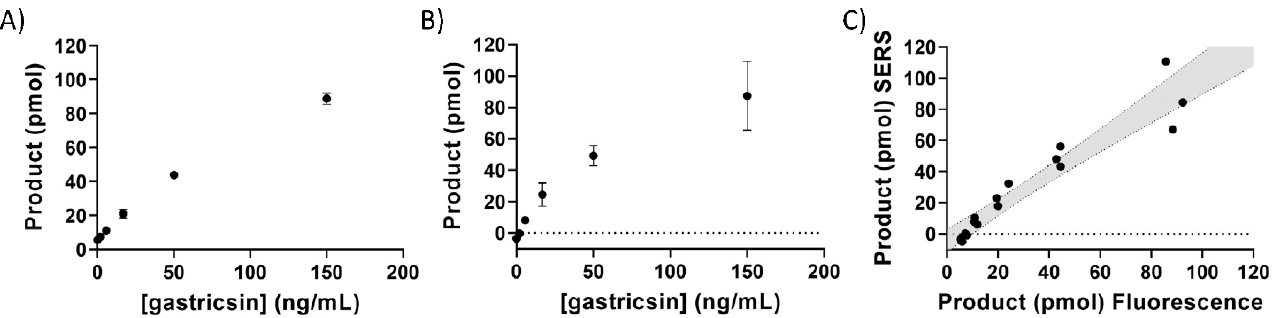
Figure 2. Gastricsin activity assay in pH 2 buffer. ( A ) The product formation is calculated from flu- orescence measurement at each concentration of gastricsin as indicated on the x-axis. ( B ) The prod- uct formation calculated from SERS measurements at each concentration of gastricsin. The samples in ( A ) were used for these measurements after addition of silver. Error bars represent the standard deviation of triplicate measurements. ( C ) Correlation of product formation between SERS and fluo- rescence measurements from paired reaction samples. The grey area is the 95% confidence interval from a linear regression analysis with a slope = 1.075 and R 2 = 0.914.